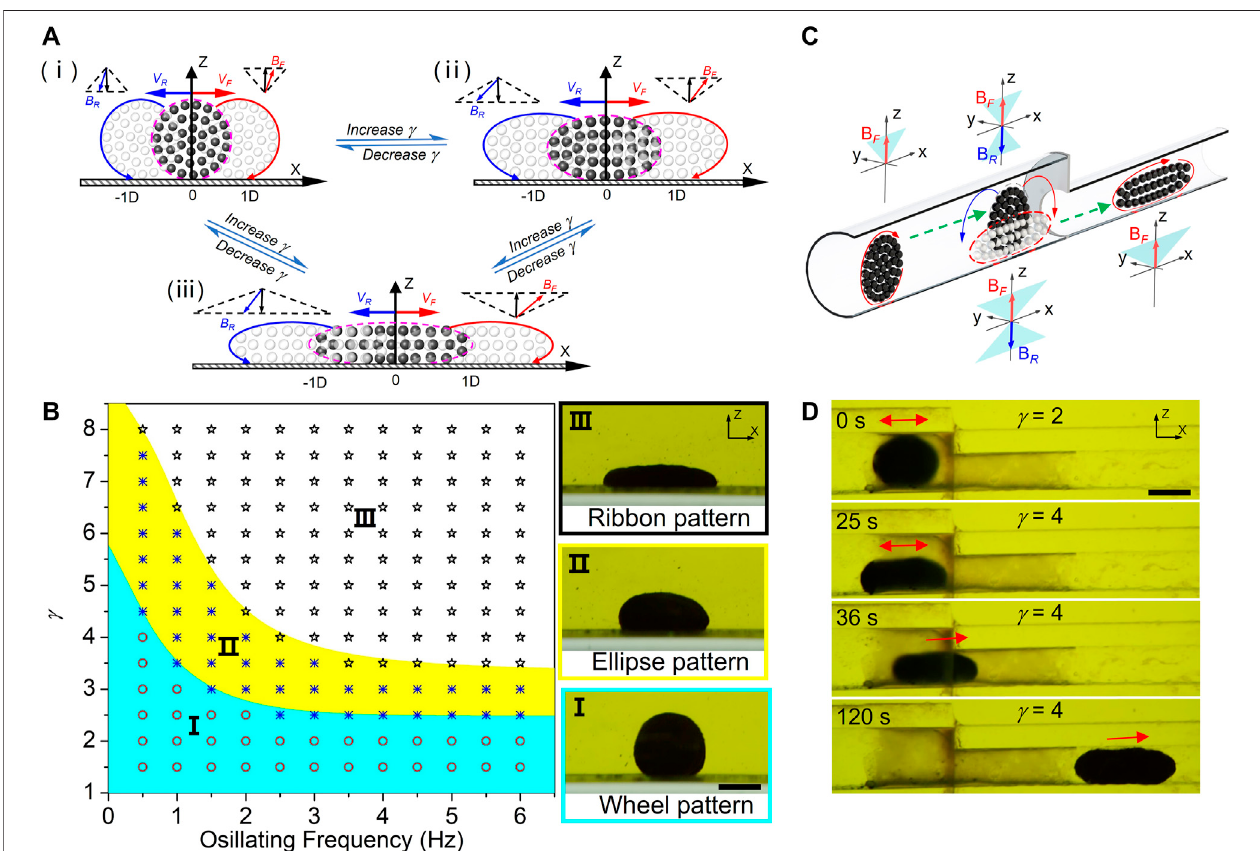
FIGURE 5 | In-situ recon fi guration of wheel-like swarms for adaptive locomotion in constrained environment. (A) Actuation strategy for in-situ recon fi guration of hoveringswarms. (i) Aschematicdepictionillustratesthehoveringwheel-likeswarm.Theamplituderatioof “ butter fl y ” swingmagnetic fi eldis γ = A / C . (ii) Verticalellipse- like swarm transformed from hovering wheel-like swarm without leaving the original place by increasing amplitude ratio γ . (iii) Vertical ribbon-like swarm transformed in place from hovering ellipse-like swarm with a further increase in γ . (B) The phase diagram presents three swarm patterns actuated by different magnetic fi elds. WheelswarmpatterncanforminregionI.Intheyellowshadowedregion,verticalellipse-likeswarmsaretriggered.Theswarmsareelongatedintoverticalribbonpattern under fi eldsinregionIII.Thescalebaris1 mm. (C) Schematicillustrationoftheadaptivelocomotionofawheel-likeswarminsteppedpipebyusing in-situ recon fi guration strategy. The green dotted lines are the desired swarm paths. (D) Demonstration of actuating a verticalswarm to travel across the stepped pipe. The scale bar is 1 mm.